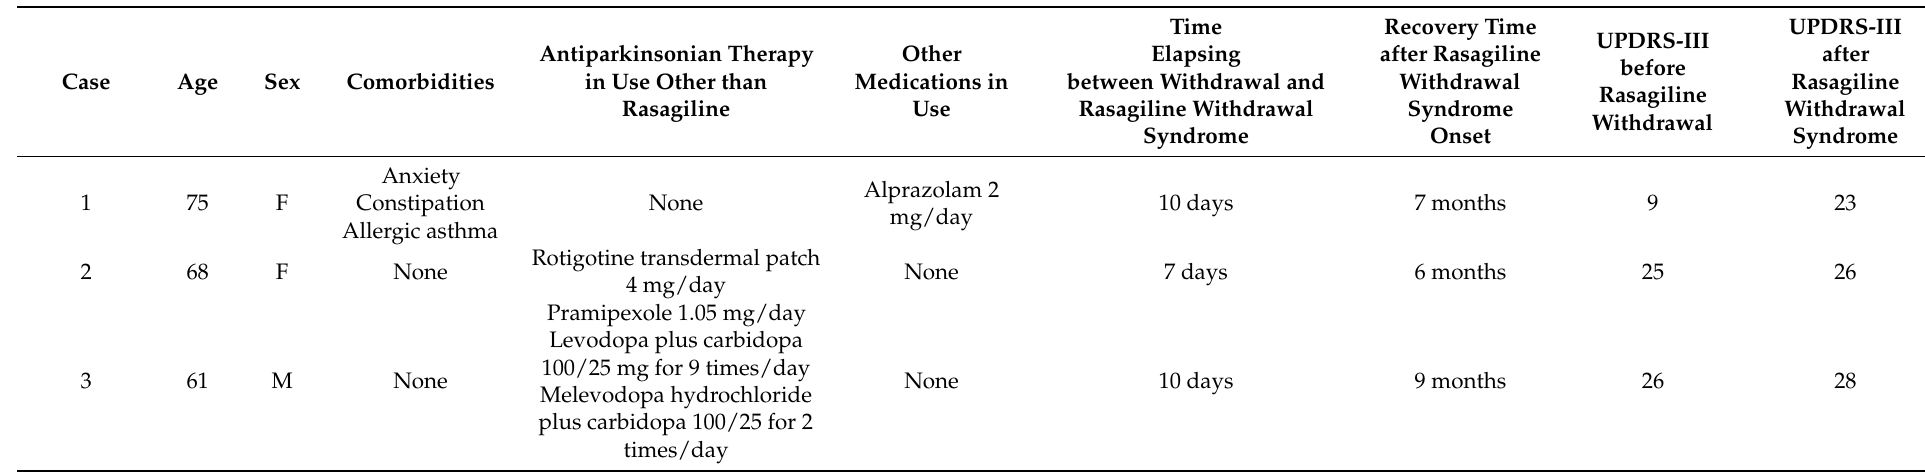
Table 1. Demographic and clinical feature of the three PD patients who developed a withdrawal syndrome after rasagiline